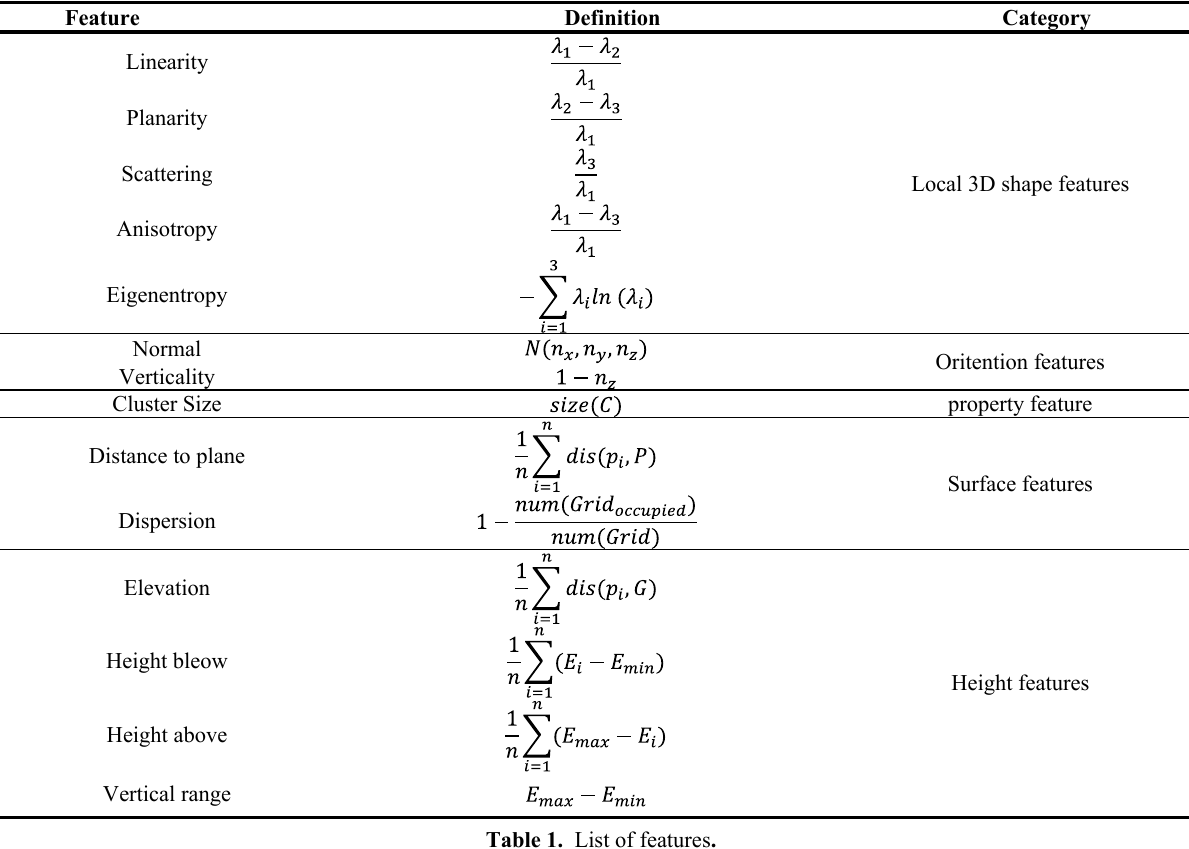
Table 1. List of features .